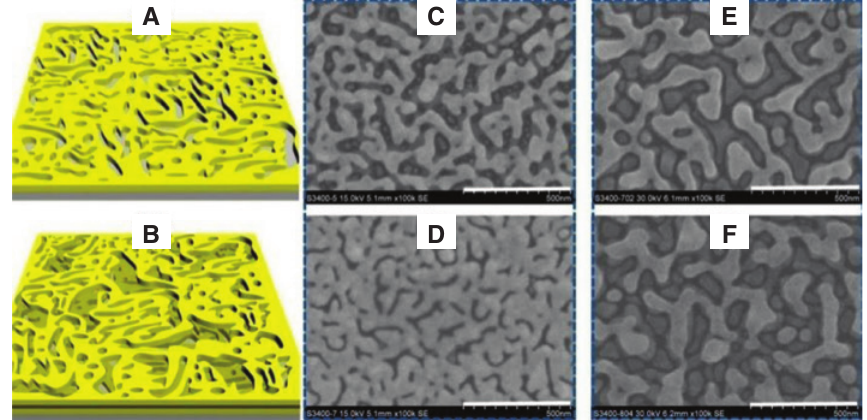
Figure 1: Schematics and scanning electron microscopy (SEM) images of the dielectric film sandwiched plasmonic clusters. Schematic of single layer Au clusters (A) and dual-layer Au clusters with an ultra-thin silicon film (B). (C) (D) Dual-layer Au clusters with a 1 nm silicon and silica film, respectively. (E) (F) Dual-layer Au clusters with a 30 nm silicon and silica film, respectively. The scale bar is 500